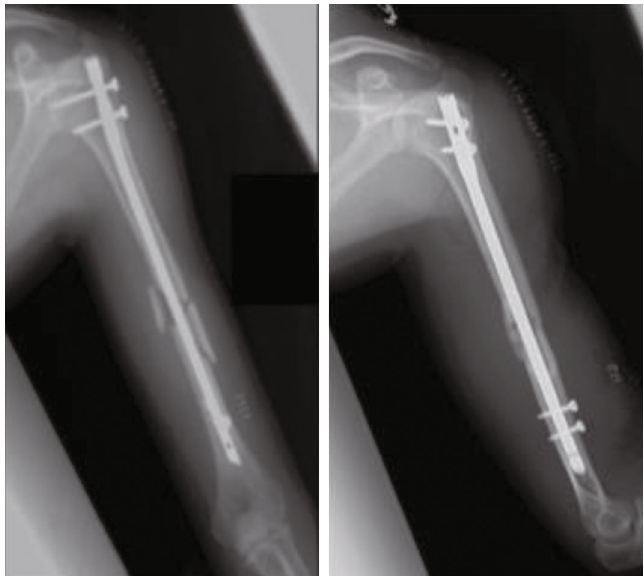
Figure 2: Radiographs just after the fi rst surgery using IMN. The surgery was performed using a curved nail 8 days after the